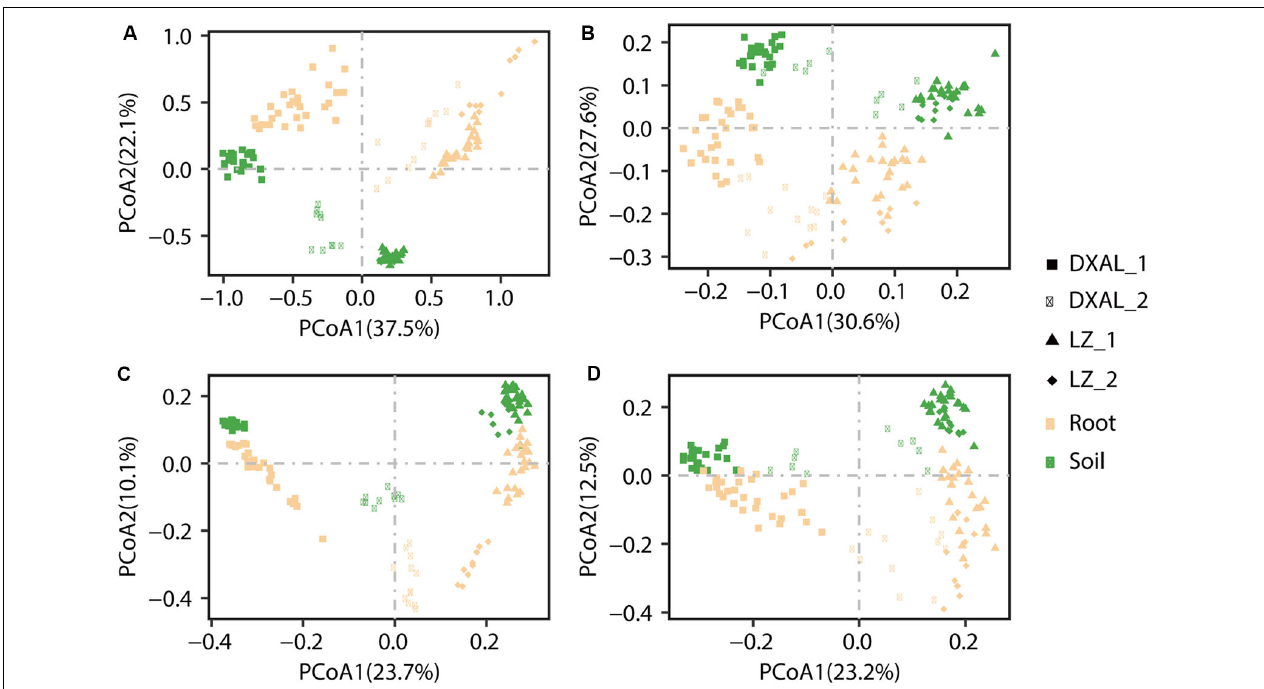
FIGURE 2 | PCoA of microbial community composition among different sample types of G. conopsea . (A) PCoA using the WUF distances at the OTU level using fungal community’s data. (B) PCoA using the UUF distances at the OTU level using fungal community’s data. (C) PCoA using the WUF distances at the OTU level using bacterial community’s data. (D) PCoA using the UUF distances at the OTU level using bacterial community’s data. Samples are color coded according to the sites, compartments, and developmental stages are depicted with different symbols. DXAL: Greater Khingan Mountains, LZ: Linzhi, 1: vegetative growth stage, 2: reproductive growth